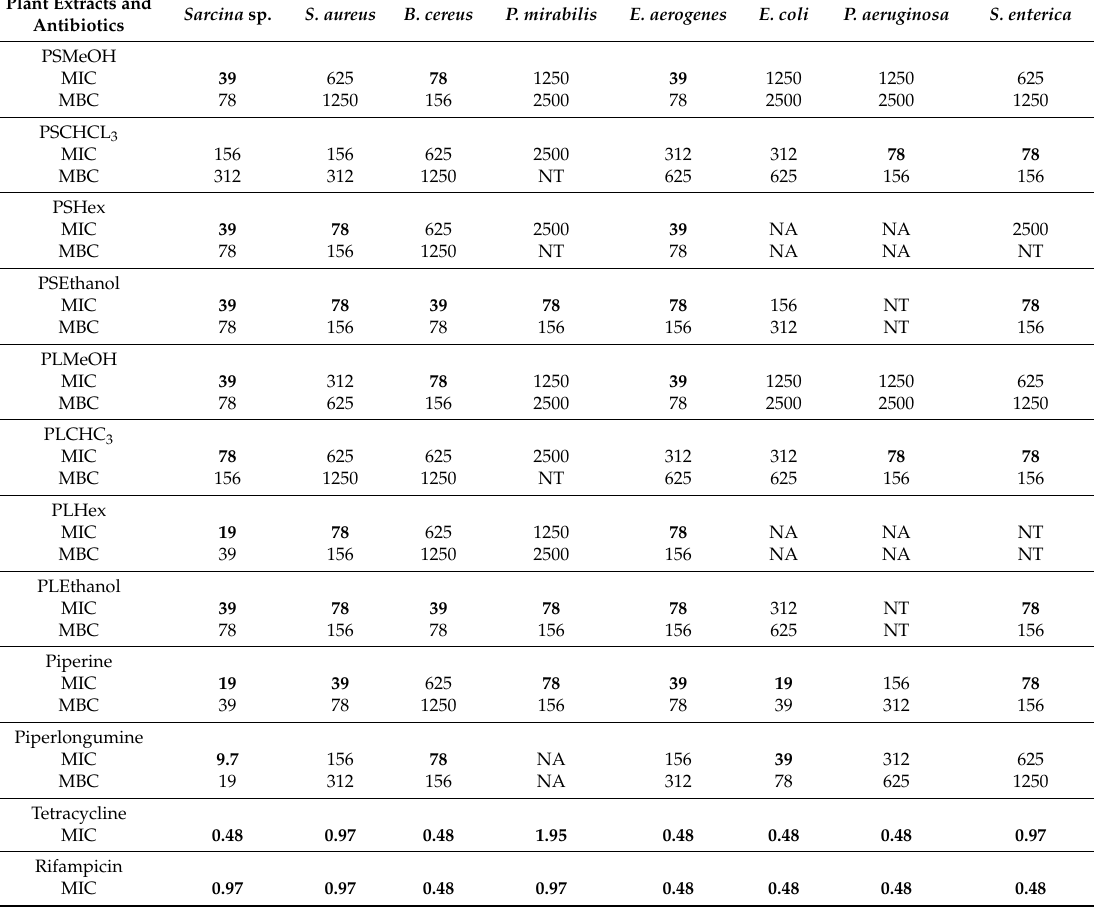
Table 3. Minimum inhibitory concentration and minimum bactericidal concentrations (MIC and MBC) in µ g/mL of fruit and leaf extracts of Piper guineense and the alkaloids piperine and piperlongumine. Plant Extracts and Sarcina Antibiotics